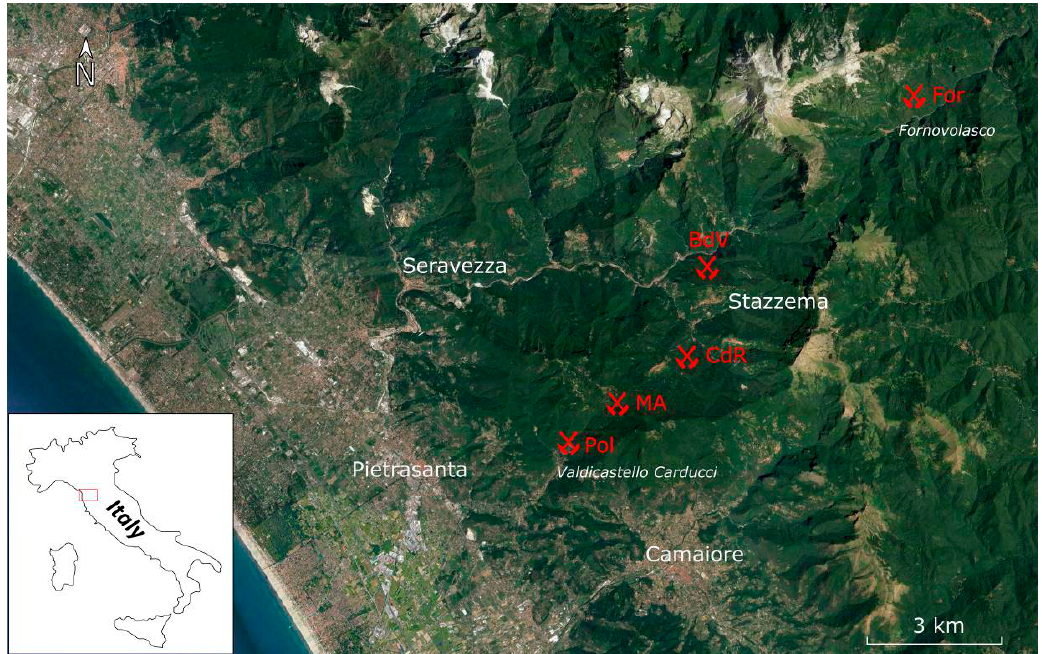
Figure 1. Map showing the localities cited in the text. Labels: BdV = Buca della Vena mine; CdR = Canale della Radice mine; For = Fornovolasco mine; MA = Monte Arsiccio mine; Pol = Pollone mine.